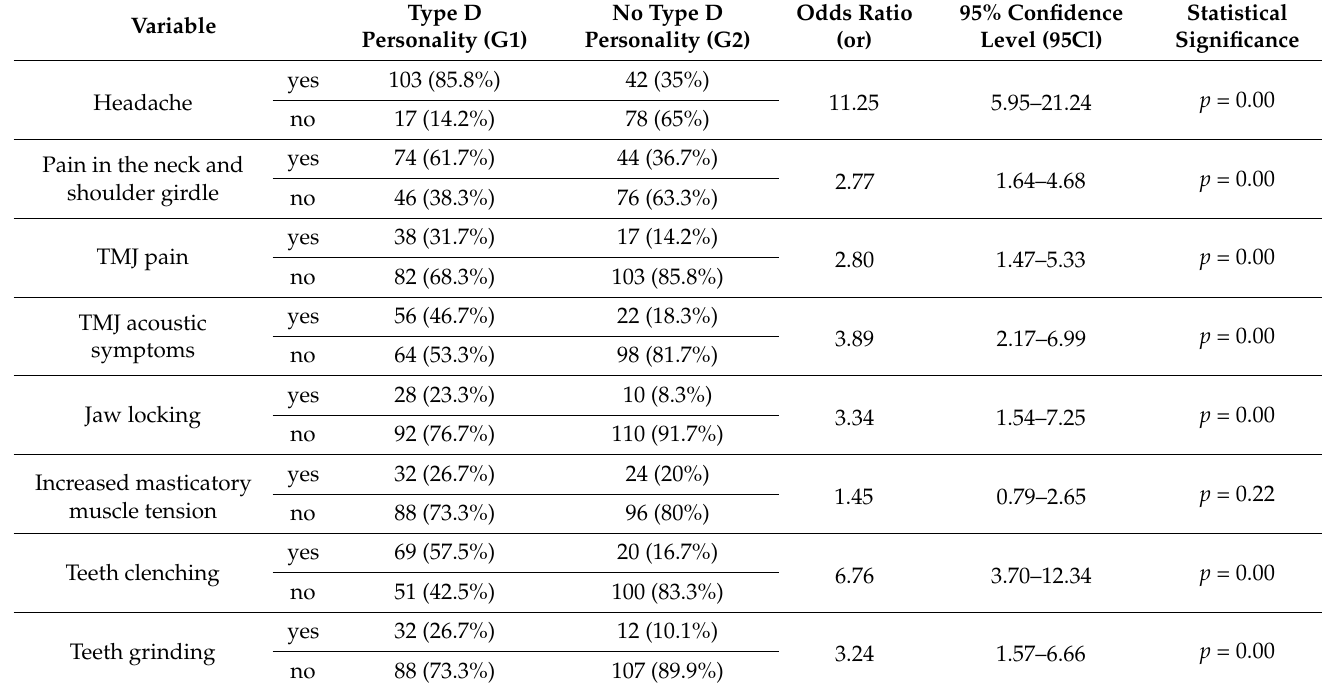
Table 1. Analysis of the occurrence of TMD symptoms in the study and control